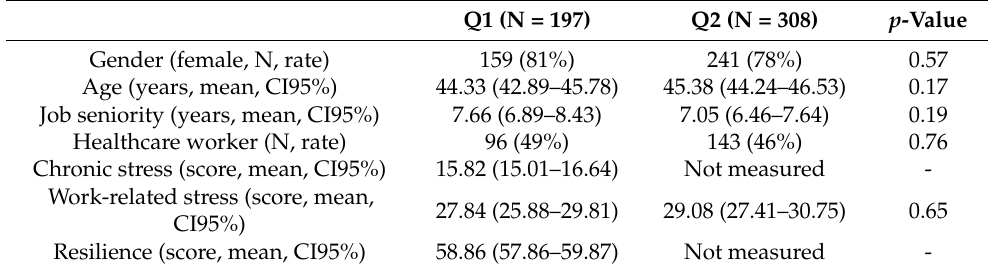
Table 1. Demographic, occupational, and survey score information of the respondents.